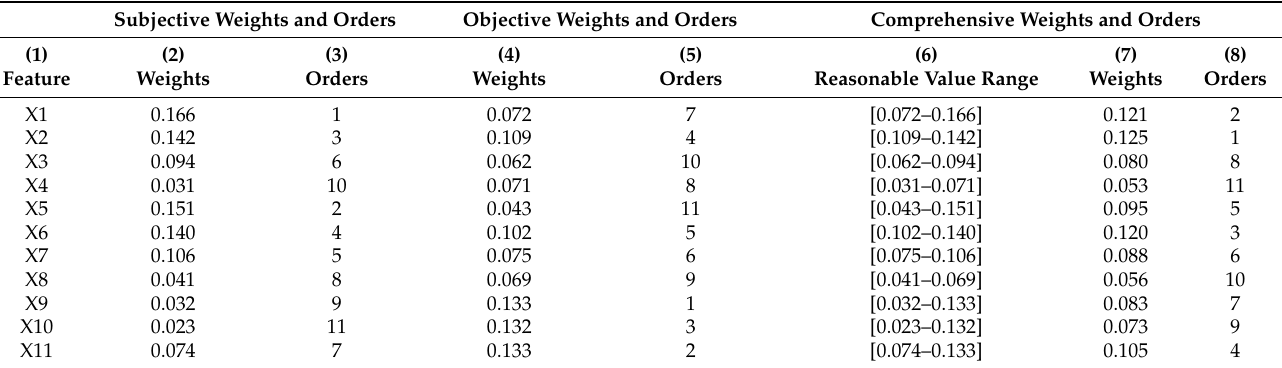
Table 5. The weight of 11 types of